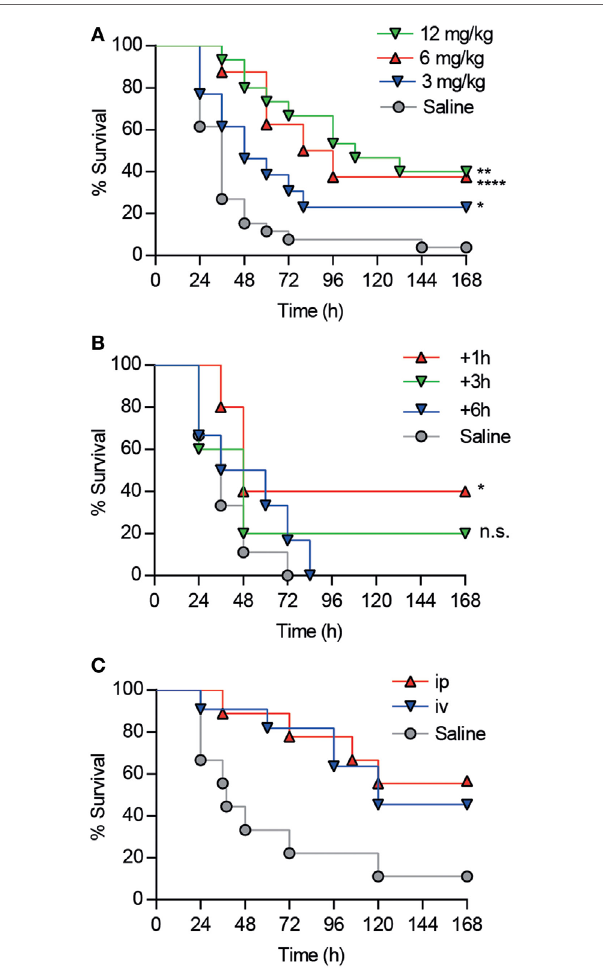
FigUre 6 | Analysis of dose-, time-, and via -dependent effects of CD6.PD3 infusion on mouse survival following cecal ligation and puncture (CLP)- induced sepsis. (a) C57BL/6 mice were intravenous ( i.v. ) infused 1 h post CLP with saline ( n = 26) or single increasing doses (3 mg/kg, n = 13; 6 mg/kg, n = 15; and 12 mg/kg, n = 8) of unlabeled CD6.PD3 peptide. (B) C57BL/6 mice were i.v. infused with saline ( n = 5) or 6 mg/kg CD6.PD3 at different times post CLP ( + 1 h, n = 5; + 3 h, n = 5; and + 6 h, n = 6). (c) C57BL/6J mice were i.v. ( n = 11) or intraperitoneally ( n = 9) infused with 6 mg/kg CD6. PD3 peptide or saline ( n = 9) 1 h post CLP. In all cases, average percentage of survival was analyzed over time and compared with the saline-treated group using a log-rank t -test (n.s., not significant; * P < 0.05. ** P < 0.01; and *** P < 0.001).